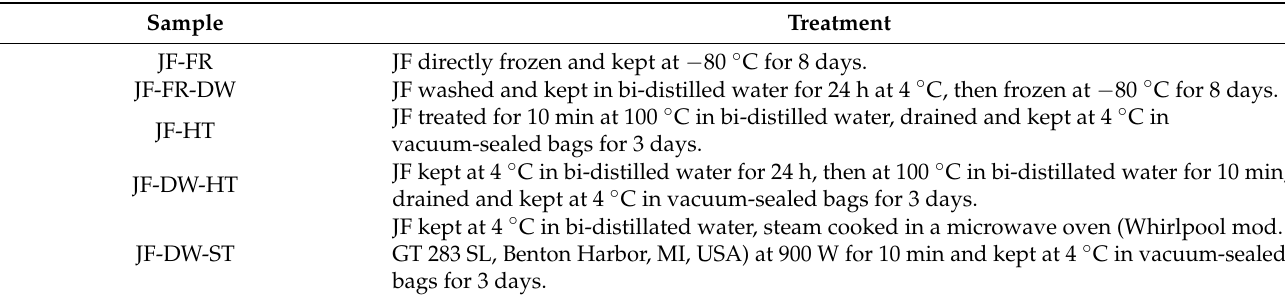
Table 1. JF sample